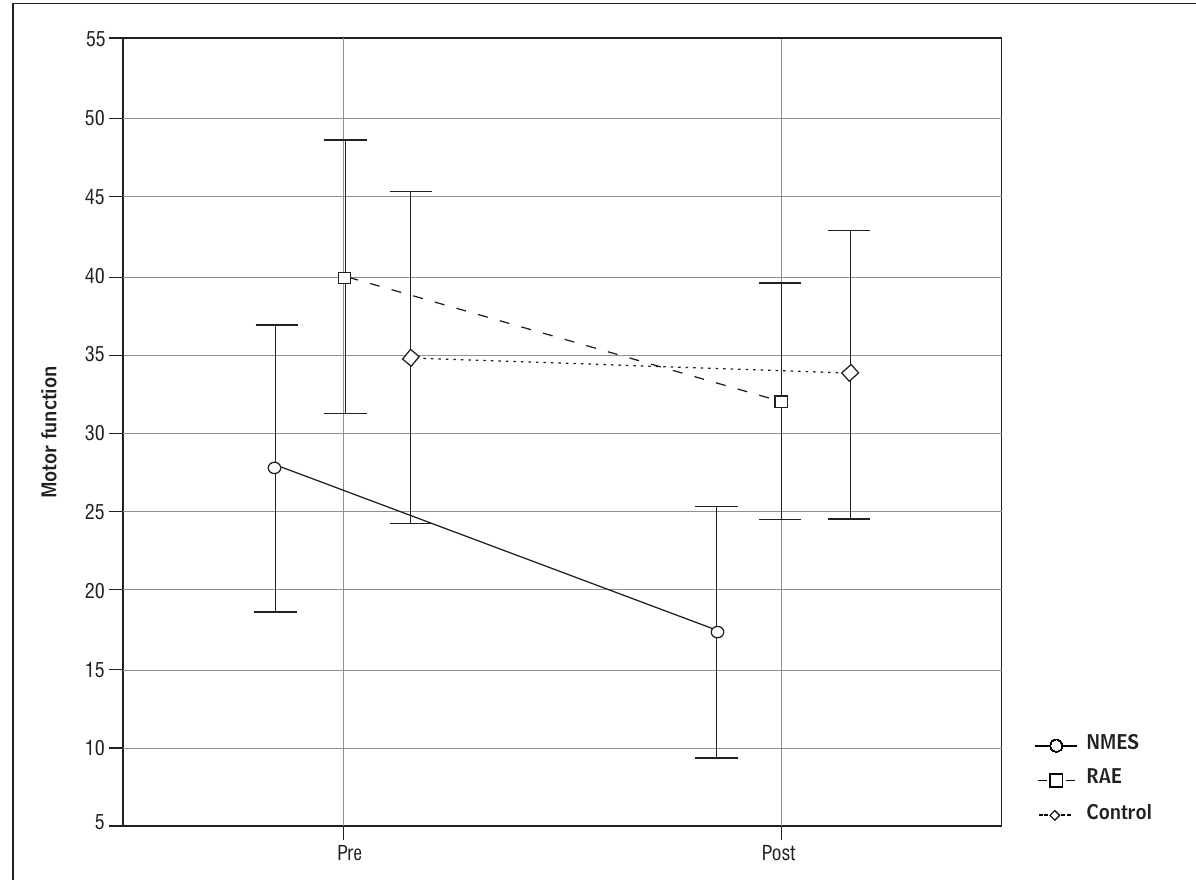
Graph 3 - Motor function before and after the 24-session program for neuromuscular electrical stimulation (NMES), resistan- ce against exercise (RAE), and control (bars represent a confidence interval of 95 % ) Source: Research